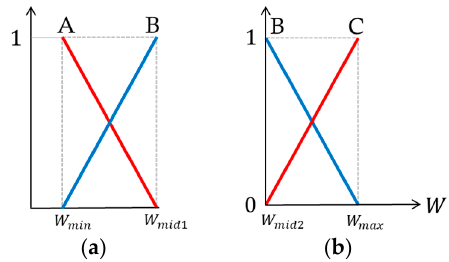
Figure 3. Fuzzy output membership functions for lower and upper limit. ( a ) Lower limit, ( b ) Up- per limit.